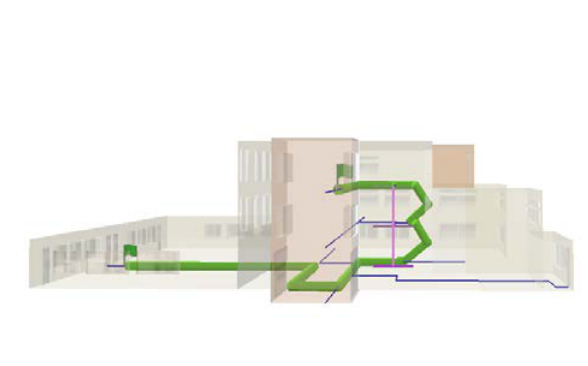
Figure 12. Visualization of the building’s exterior shell and the routes simultaneously